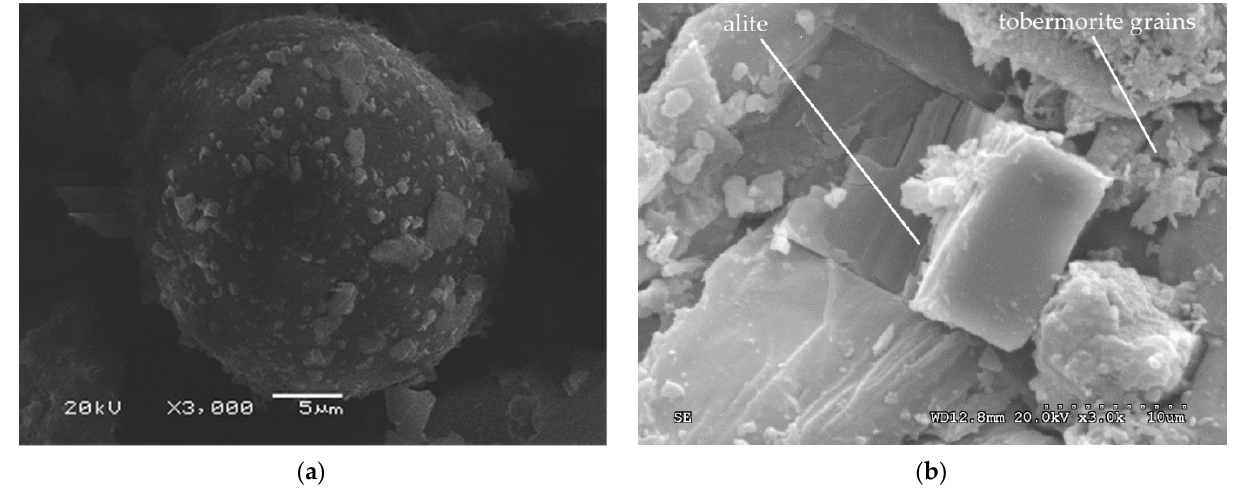
Figure 11. ( a ) Belite 8 days after hydration and ( b ) tobermorite, alite and portlandite 8 days after hydration.